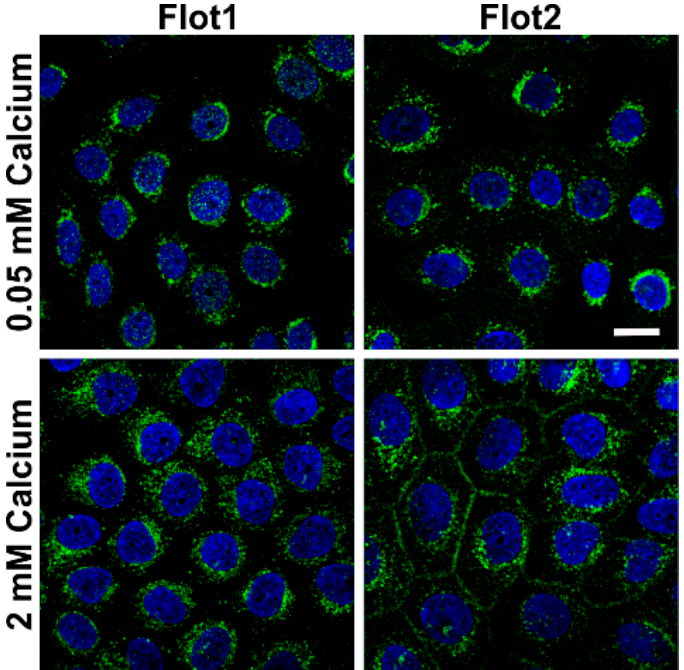
Figure 1. Effect of calcium concentration on the localization of desmogleins in human telomerase reverse transcriptase (hTert) cells. The cells were grown on coverslips in Keratinocyte growth medium (KGM) with 0.05 mM calcium for at least four days, and then shifted to 2 mM calcium for 24 h. After methanol (MeOH) fixation, the cells were stained with anti-desmoglein (Dsg) antibodies and fluorochrome coupled secondary antibodies (anti-mouse Alexa488, green). The coverslips were mounted in a mounting medium with 4 (cid:48) ,6-diamidino-2-phenylindole (DAPI, blue) to visualize nuclei. n = 4 independent experiments, scale bar 20 µ m.